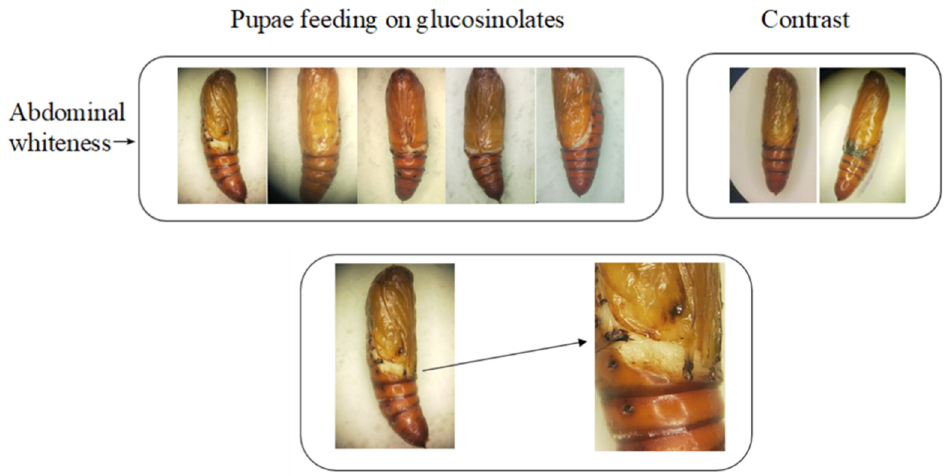
Figure 1. Growth and development of cotton bollworm larvae. The development period of the H. armigera at different instars under different concentrations of glucosinolate. Error bars indicate standard errors of the means (SE) ( n = 100). Letters indicate values that are statistically different from the control group ( p < 0.05).